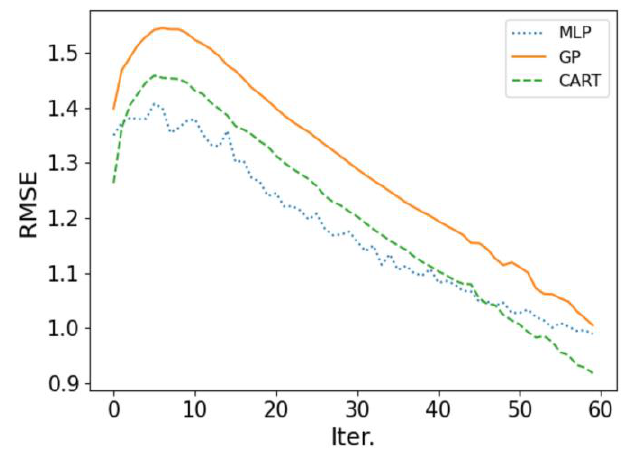
Figure 4. Root mean square error comparison of surrogate models.